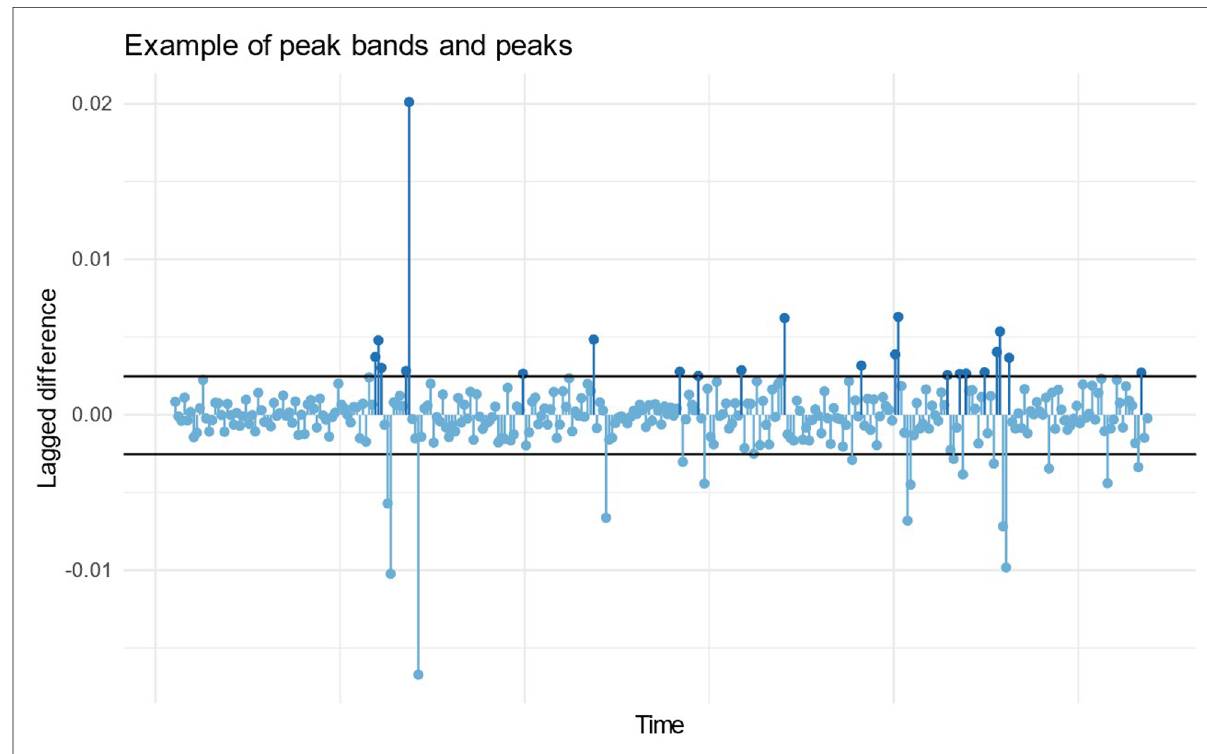
FIGURE 2 Example of a peak band and the peaks (dark blue markers) in a random sample of EDA data over couple of